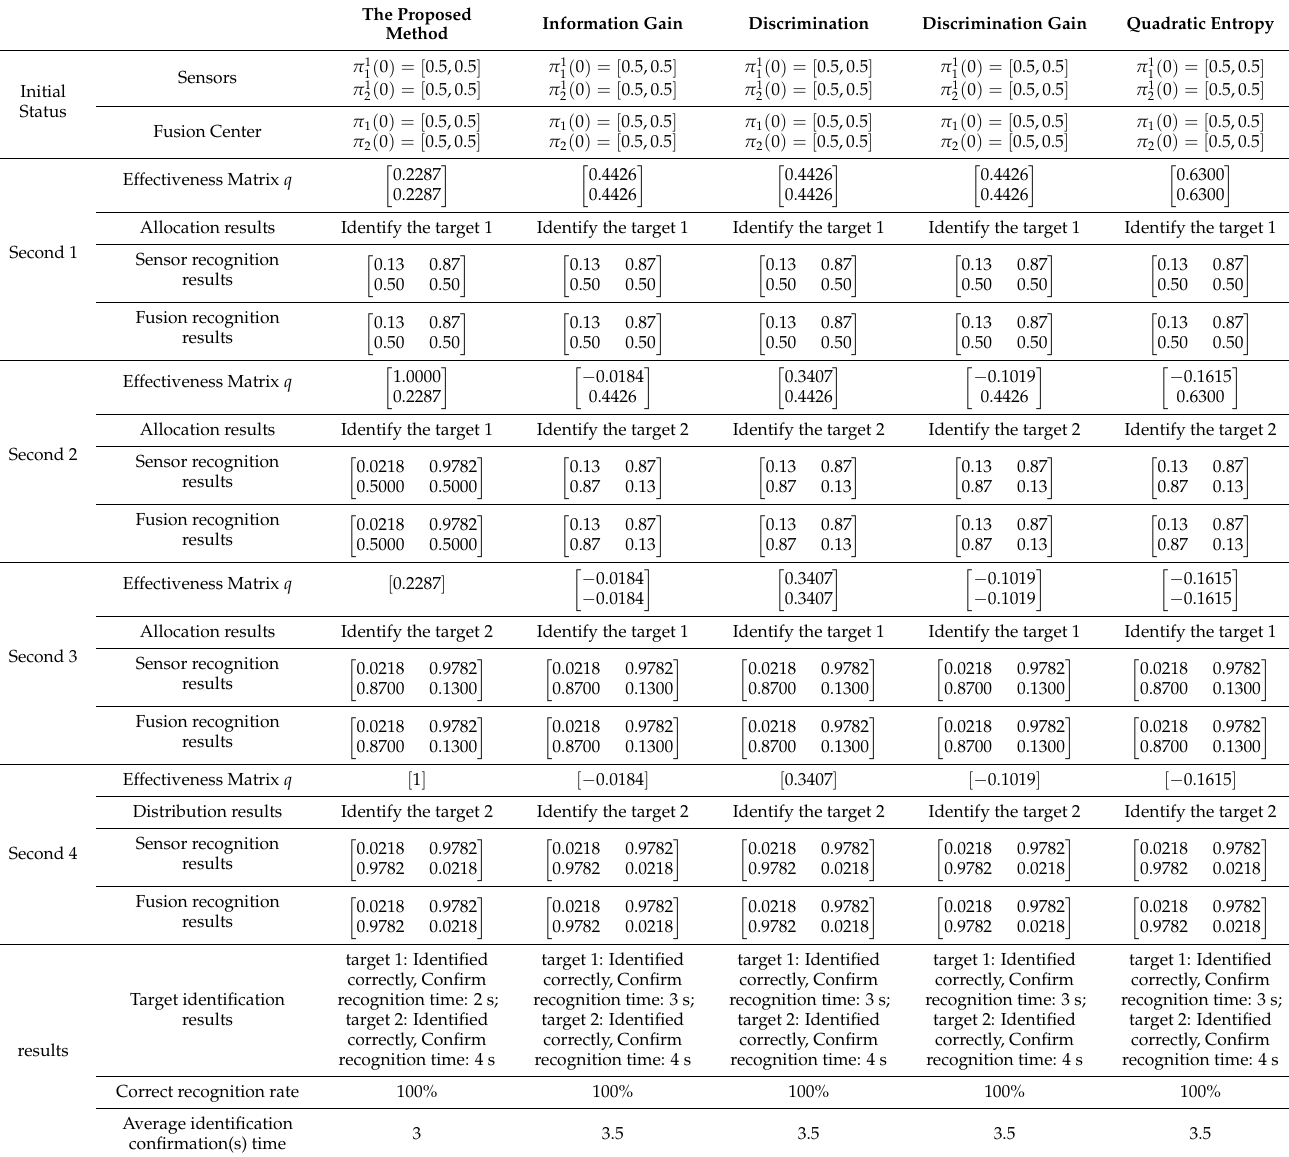
Table 1. Processing of sensor recognition of 2 targets in scenario